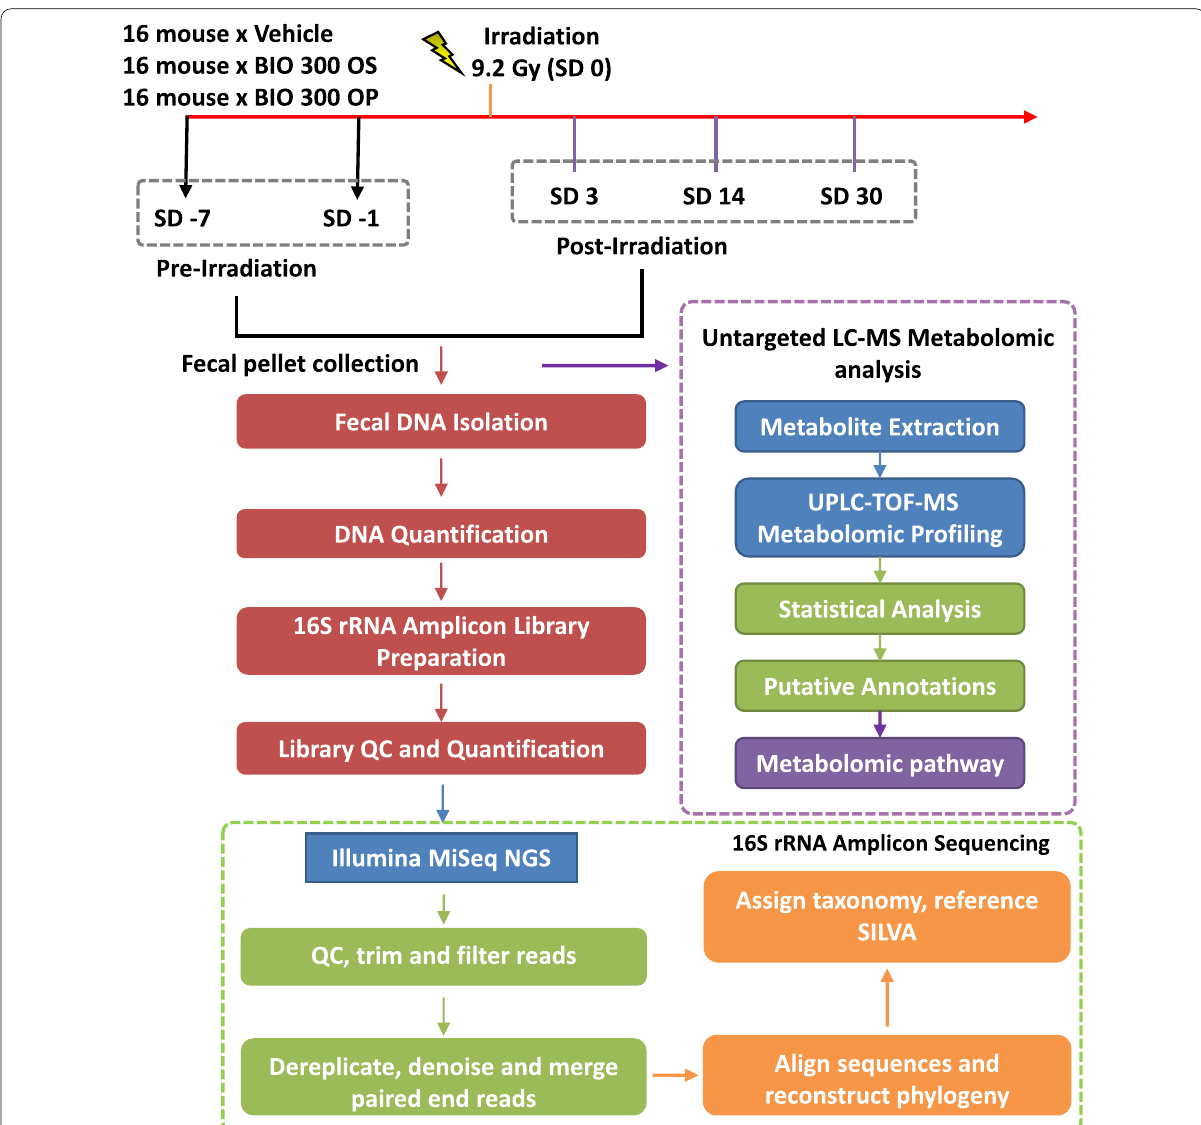
Fig. 1 Experimental and analytical design of the study. Radioprotective efficacy, microbiome, and metabolomic studies of two different formulations of BIO 300, OS and OP, were conducted in irradiated CD2F1 male